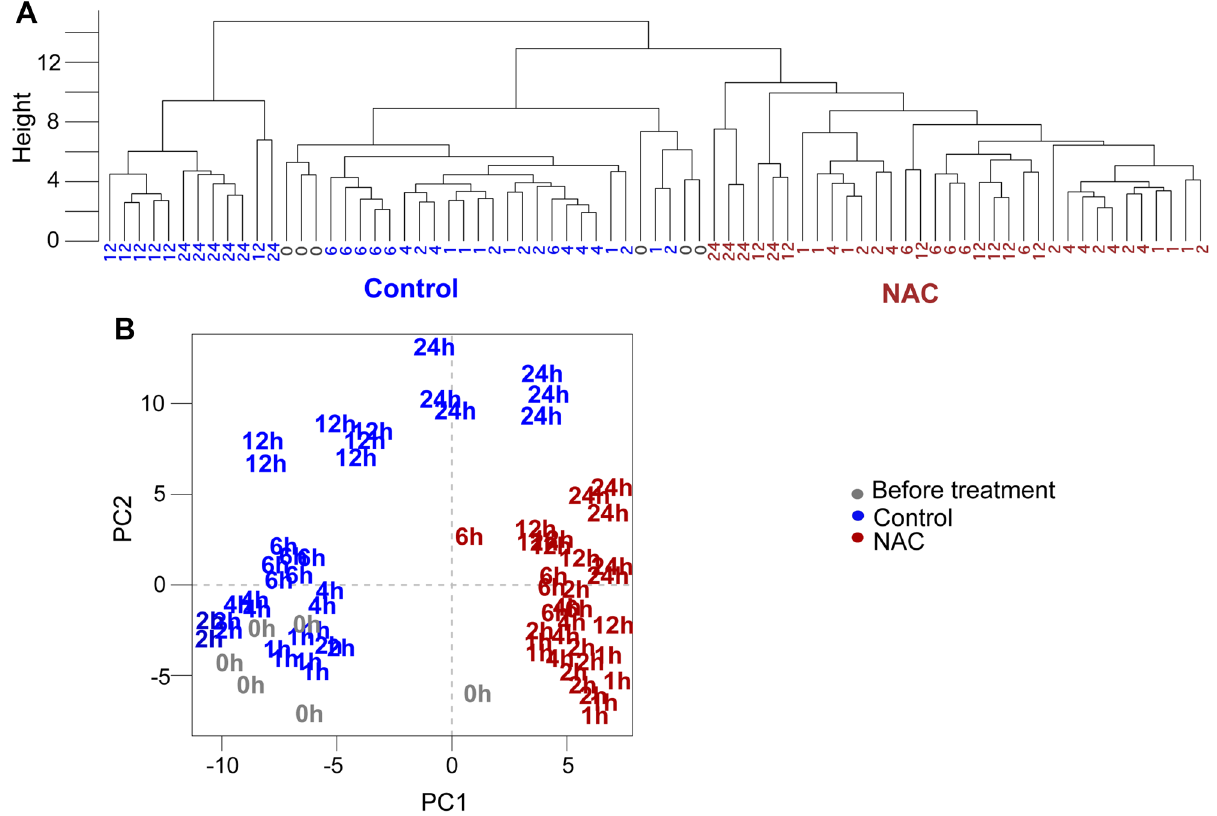
Figure 3. Hierarchical Clustering Analysis ( a ) and Principal Component Analysis ( b ) HCA was performed by average linkage clustering method using Euclidean distance. Samples are named according to the time points (hours) and colored coded according to treatment (before treatment -gray; control-blue and